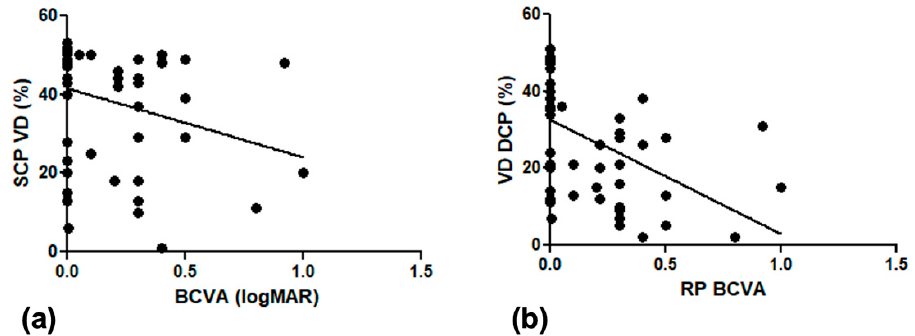
Figure 4. Scatterplots showing the relationship between vascular density in superficial capillary plexus ( a ) and deep capillary plexus ( b ) and best-corrected visual acuity (BCVA), expressed in LogMAR, in retinitis pigmentosa patients.